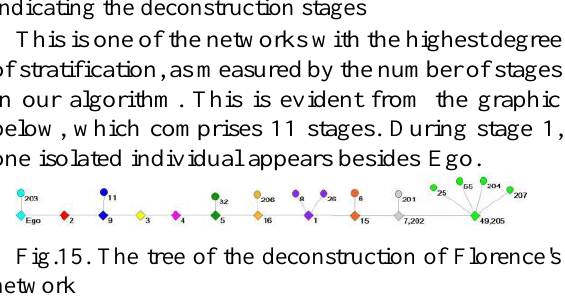
Fig.15. The tree of the deconstruction of Florence's network During the second stage, as well as during the 4th and 5th stages, intermediaries are identified but no